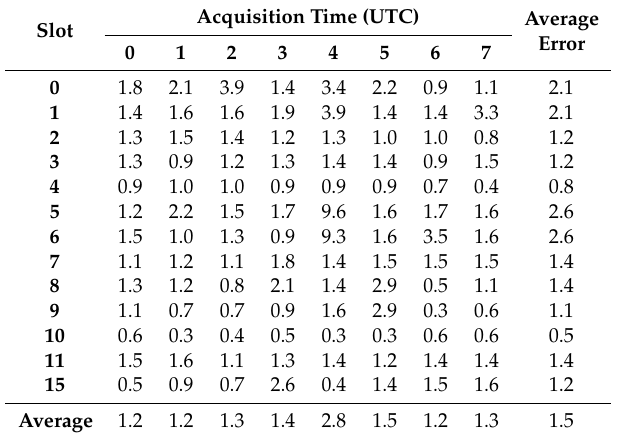
Table 6. RMSE of geometric correction with frequency matching (includes outliers) (in km).